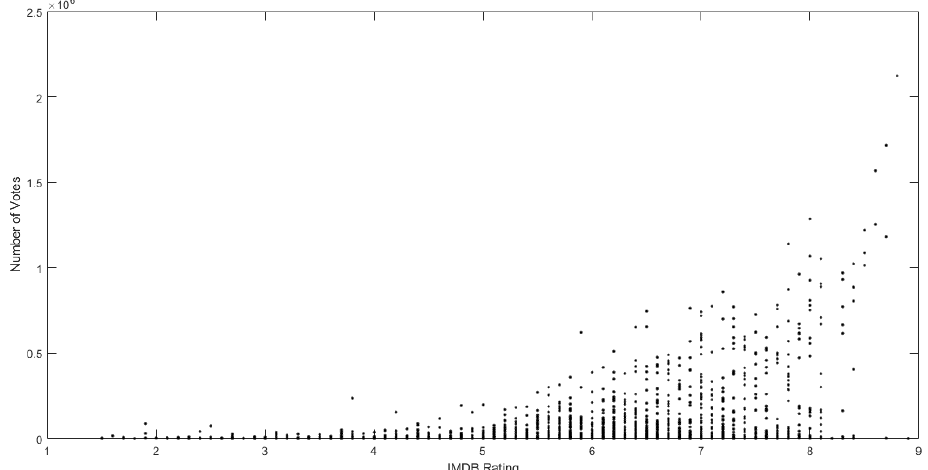
Figure 3. Relationship between IMDB Rating and Number of Votes. The highest-grossing science fi ction movies of all time are shown in Table 3.